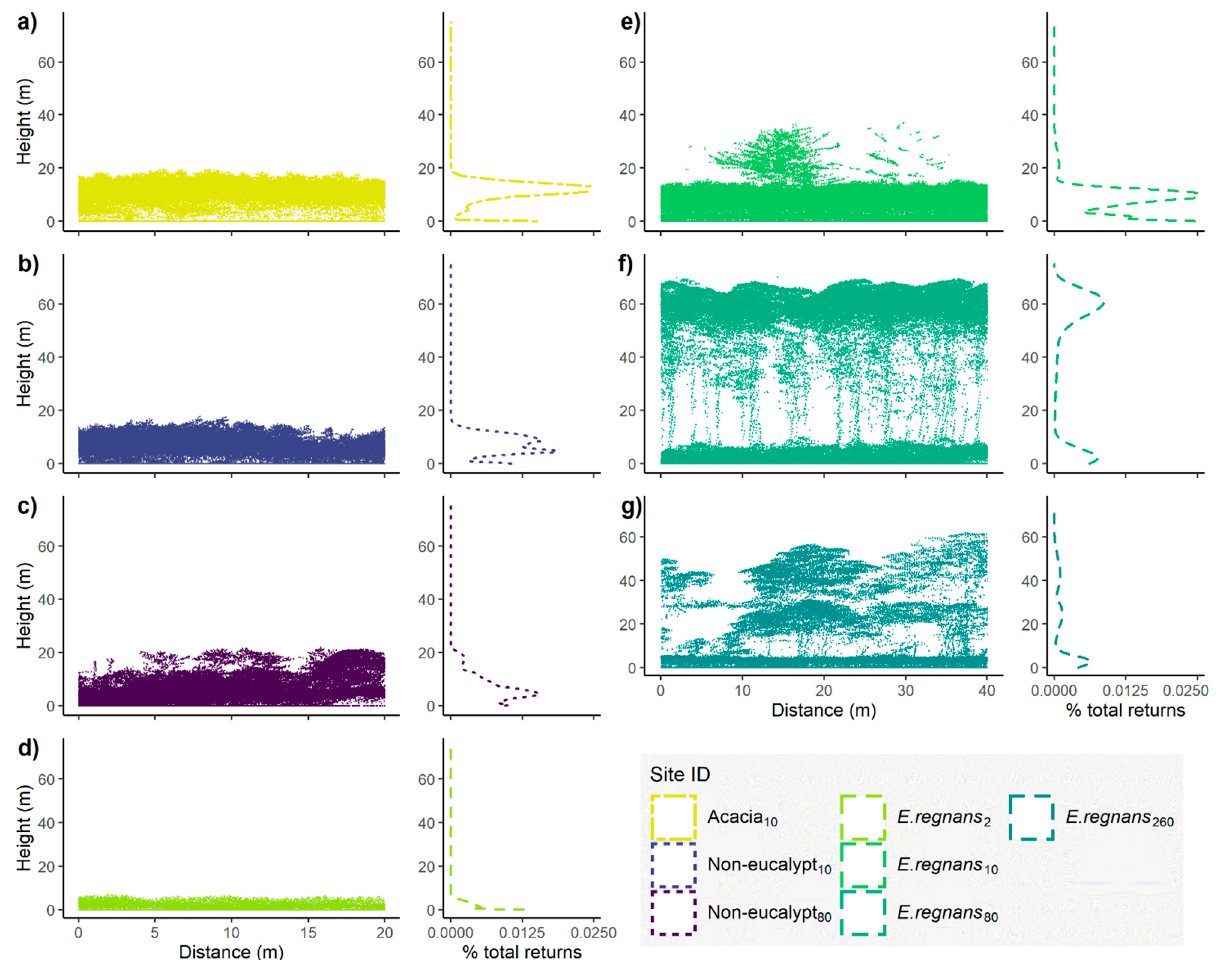
Figure 3. Point cloud profiles (left) and percentage return profiles (right) for instrumented field sites: ( a ) Acacia 10 , ( b ) Non-eucalypt 10 , ( c ) Non-eucalypt 80 , ( d ) E. regnans 2 , ( e ) E. regnans 10 , ( f ) E. regnans 80 and ( g ) E. regnans 260 . The dead stag has not been filtered from E. regnans 10 instrumented site for this figure.